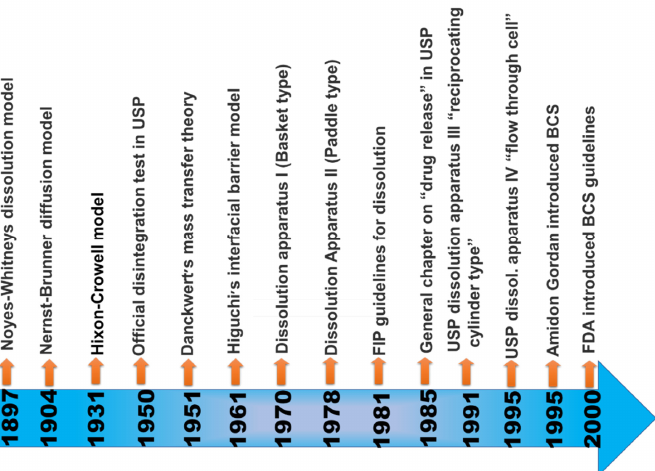
Figure 3. Evolutionary history of biopharmaceutical classification system [26].